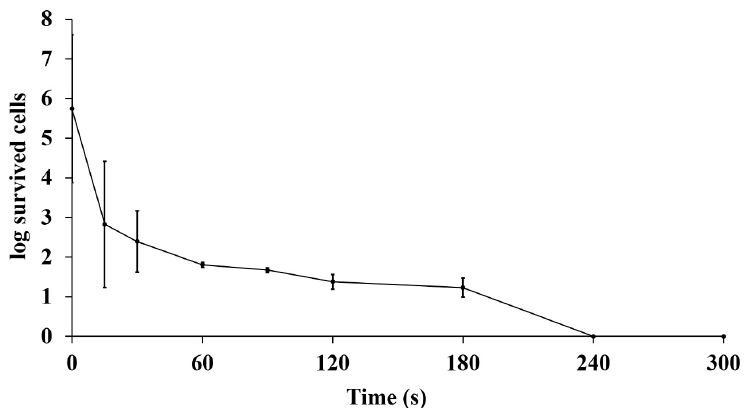
Figure 3. The survival curve of Brevibacillus sp. SRP-20 at different time intervals when exposed to UV radiation. The results are expressed as mean ± SD ( n = 3). Table 4. Comparison of antibacterial activity between Brevibacillus sp. SPR-20 and its mutant strains by agar well diffusion (means ± SD; ( n = 3).